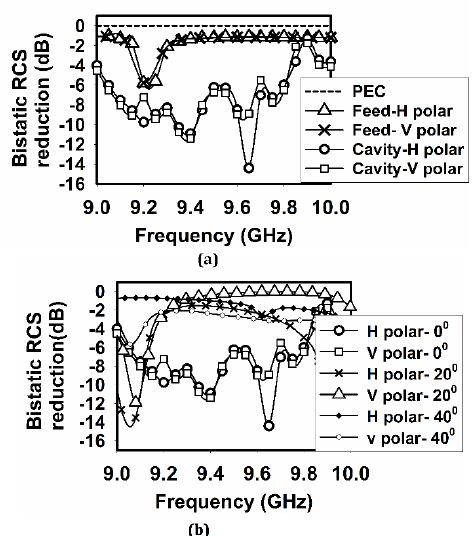
Figure.12. RCS reduction for (a) normal incidence (b) oblique